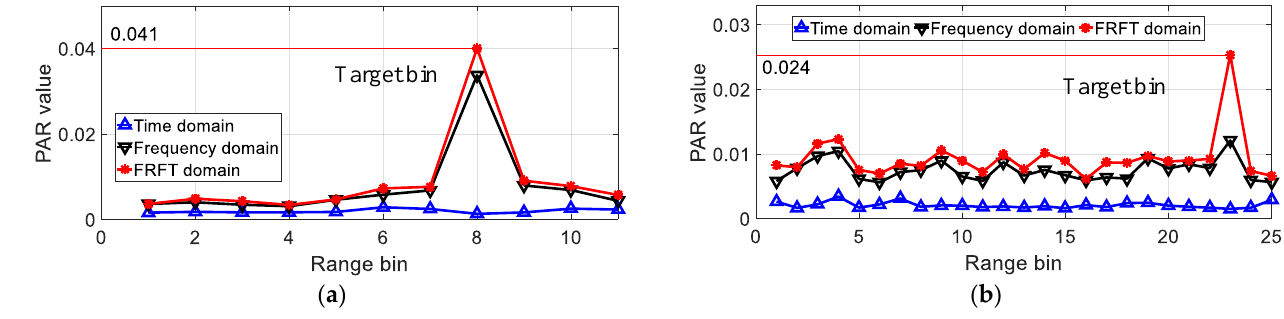
Figure 10. Comparison results of peak average ratio. ( a ) IPIX-#1. ( b ) IPIX-#11.